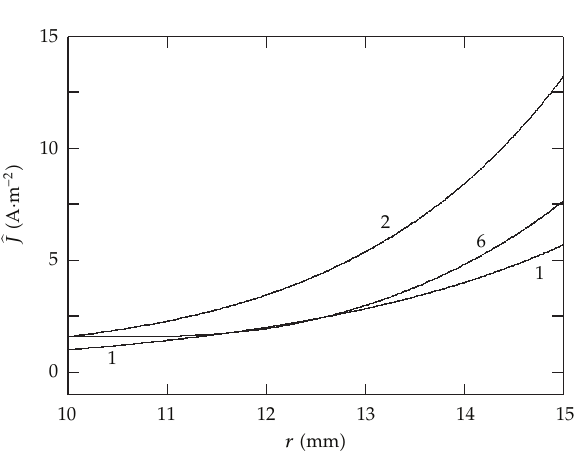
Figure 5: Solution of Example 3.3 in outer conductor. Variants 1, 2 and 6 are specified in the text. The number of partial conductors in inner and in outer conductor equals